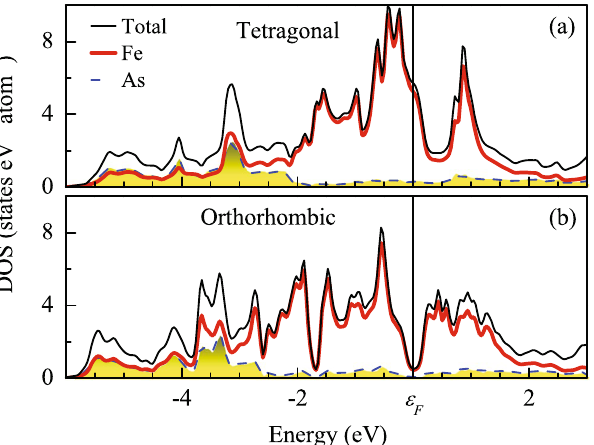
Figure 4. Calculated total density of states and the contributions from Fe & As in the ( a ) tetragonal and ( b ) orthorhombic phase.